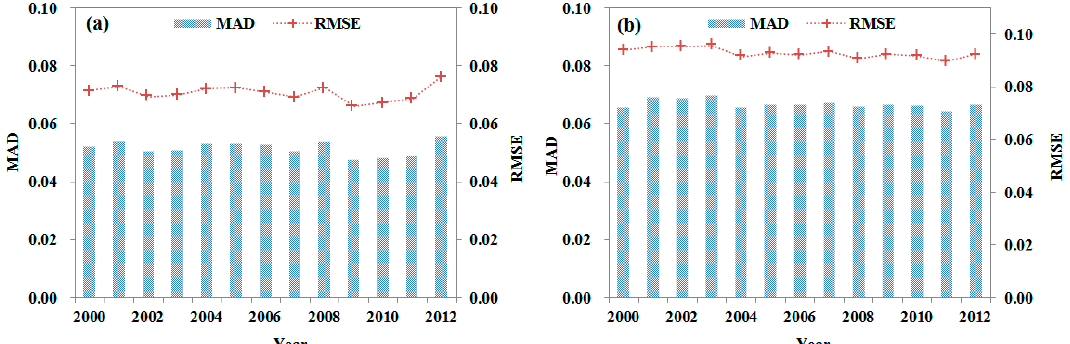
Figure 13. Inter-annual variation of the mean root-mean-square error (RMSE) and mean absolute difference (MAD) for the fusion result: ( a ) Qinghai-Tibet Plateau; ( b ) Amazon area.